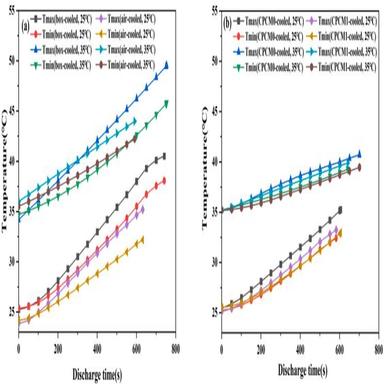
The variation of battery temperature at different ambient temperature at discharge rate of 2C: (a) temperature rise under box and air cooled (b) temperature rise under CPCM0 and CPCM1 cooled.